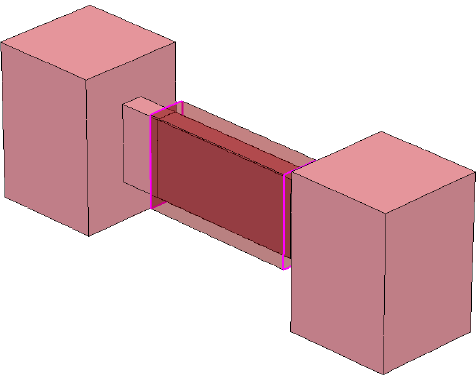
Figure 10. Structure of the GAAFET after optimization using genetic algorithm.